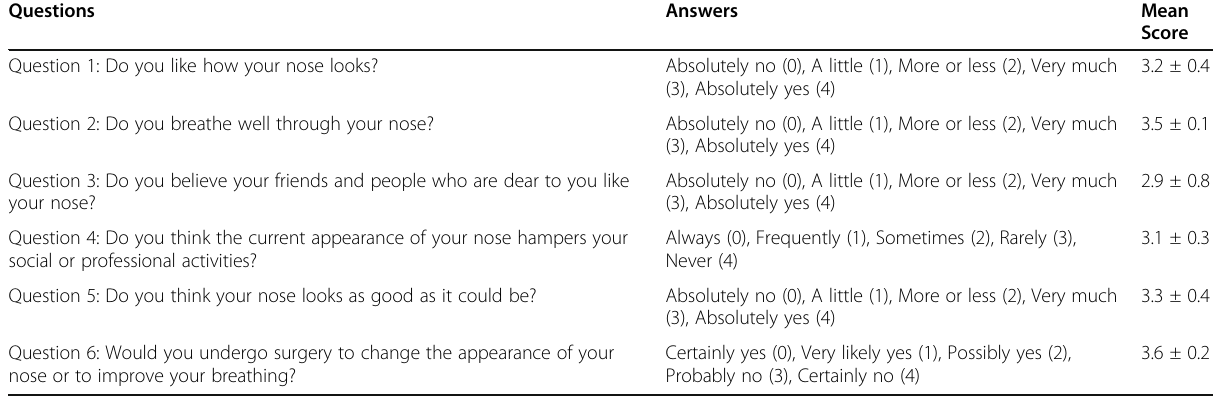
Table 1 The mean score of patients ’ satisfactions who filled the Rhinoplasty Evaluation Form (ROF) at the end of their follow-up